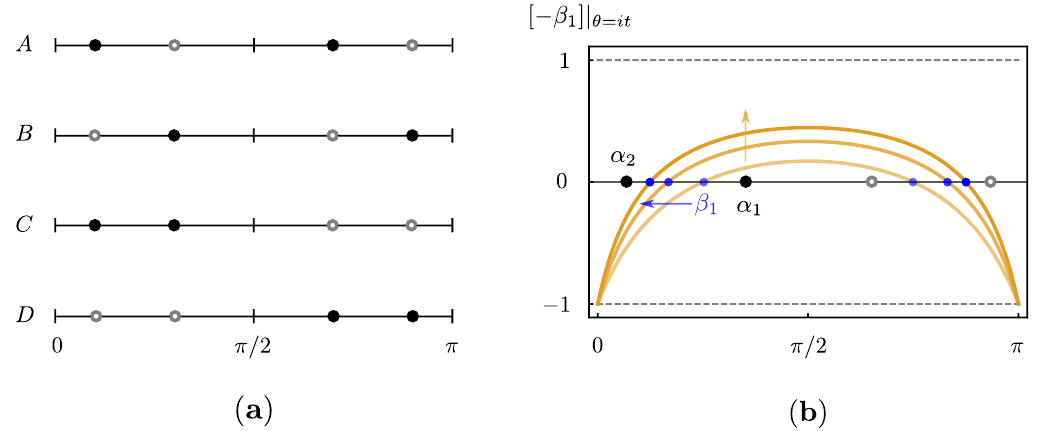
Figure 9 . Panel (a) shows the four possible con(cid:12)gurations of poles for a spectrum m 1 < m 2 < 2 m and no cubic coupling. Cases A and B correspond to m 1 < p 2 < m 2 the former with m 2 > 4 m 2 1 2 (cid:0) and the latter with m 2 < 4 m 2 . Cases C and D correspond to p 2 < m 1 < m 2 and m 1 < m 2 < p 2 1 2 (cid:0) respectively. The residues of a product of CDD factors alternate between positive and negative since a CDD factor changes sign at each of its poles and nowhere else. Thus in case A and B we can arrange for (2.3) to be satis(cid:12)ed simply by (cid:12)xing the overall sign of the S-matrix. Cases C and D cannot be repaired in this way. Instead we must multiply by a CDD zero in order to (cid:12)x the signs. Panel (b) shows a CDD zero factor [ (cid:12) 1 ] with (cid:11) 2 < (cid:12) 1 < (cid:11) 1 such that is changes sign (cid:0) between the two s-channel poles and also between the two t-channel poles. In this way the product [ (cid:11) 1 ][ (cid:12) 1 ][ (cid:11) 2 ] will have the correct residues (the overall sign can be then (cid:12)xed as in cases A and (cid:6) (cid:0) B ). The precise value of (cid:12) 1 must then be (cid:12)xed to maximize g 2 which is the residue at (cid:11) 1 . We see 1 that [ (cid:12) 1 ] grows monotonically as we shift the zero to the left toward (cid:11) 2 . Optimizing then implies (cid:0) that we must collide this zero with the pole at (cid:11) 2